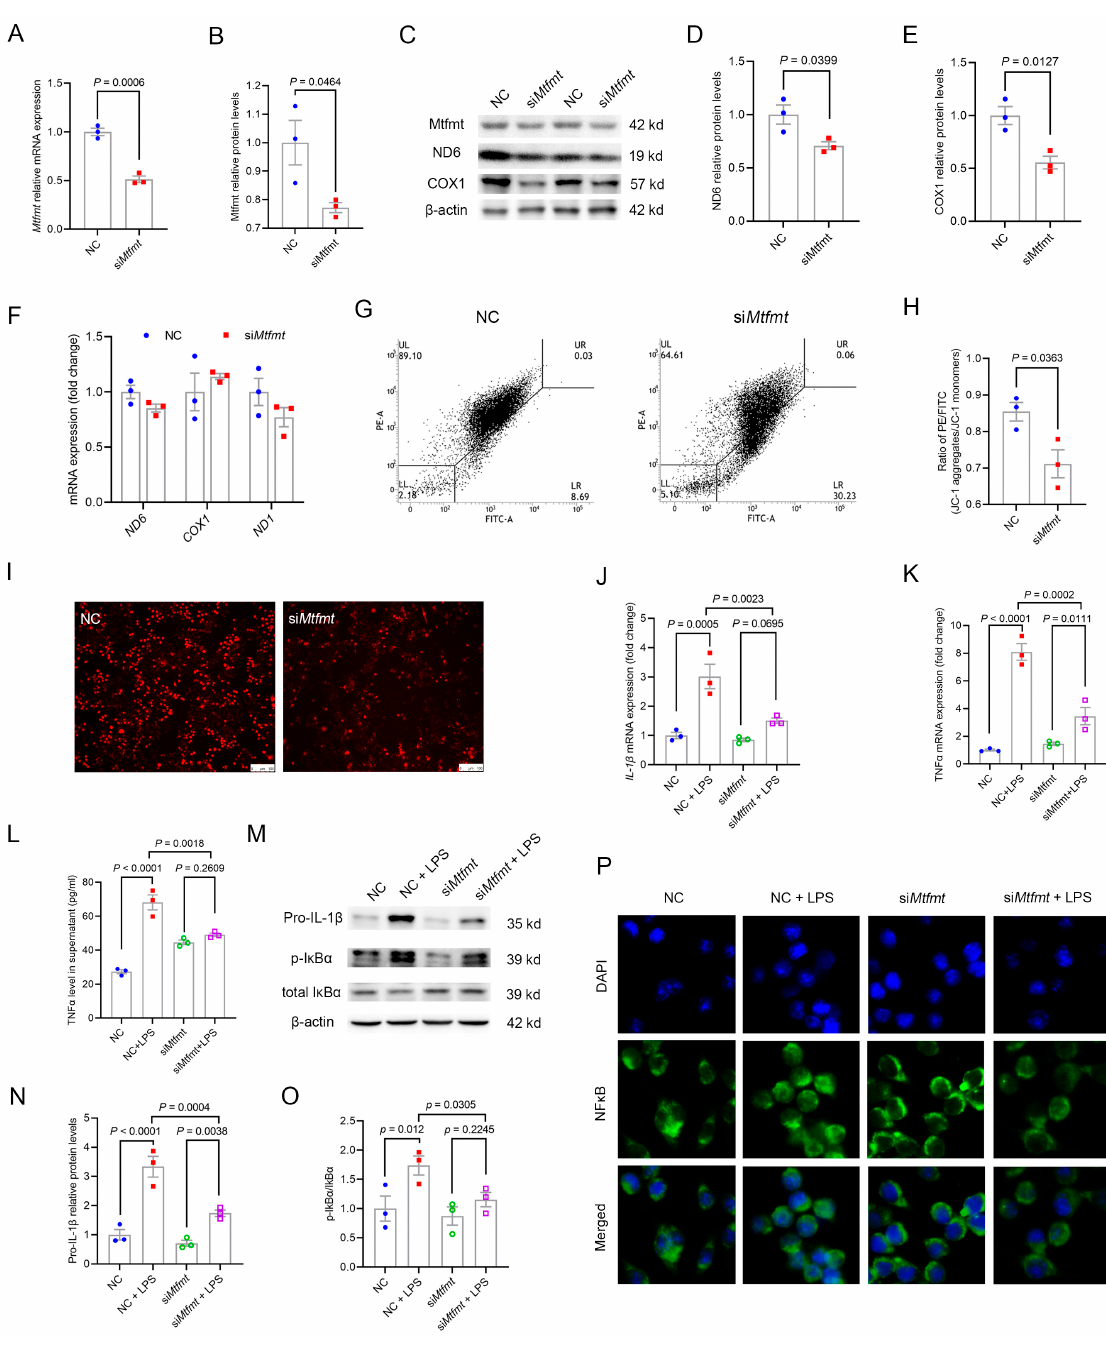
Figure 6. Mtfmt knockdown in macrophages decreased mitochondrial activity and mROS signaling and blunted NF κ B signaling. Mtfmt siRNA was transfected into Kupffer cells for 24 h. ( A ) The mRNA levels of Mtfmt were determined by quantitative real-time PCR. ( B ) Histogram showing quantification of Mtfmt protein levels. ( C ) Protein levels of Mtfmt ND6 and COX1 were determined by Western blot analysis. ( D ) Histogram showing quantification of ND6 protein levels. ( E ) Histo- gram showing quantification of COX1 protein levels. ( F ) mRNA levels of mtDNA-encoded genes. ( G ) Kupffer cells were transfected with control or Mtfmt siRNA and stained with JC-1 to measure mitochondrial membrane potential by flow cytometric analysis. ( H ) Histogram showing rates of high mitochondrial membrane potential cells. ( I ) Kupffer cells were transfected with control or Mtfmt siRNA and stained with MitoSOX to measure mROS (scale bar, 100 μ m). ( J , K ) mRNA levels of IL-1 β and TNF α were determined by quantitative real-time PCR. ( L ) TNF α levels in supernatants were measured by ELISA. ( M ) Protein levels of Pro-IL-1 β , p-I κ B α , and total I κ B α were determined by Western blot analysis. ( N ) Histogram showing quantification of IL-1 β protein levels. ( O )